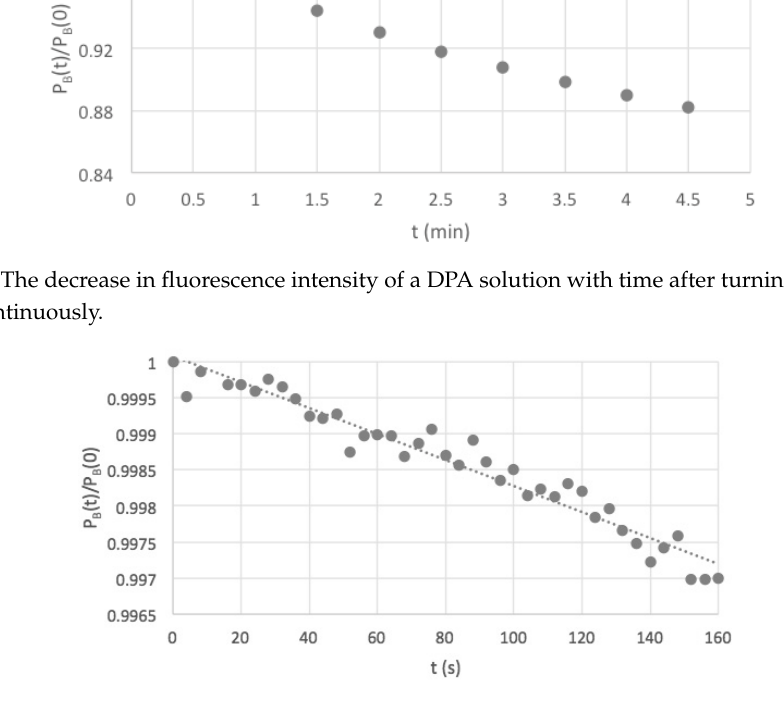
Figure 8. The decrease in fluorescence intensity of a DPA solution with time after turning on the UV lamps continuously.